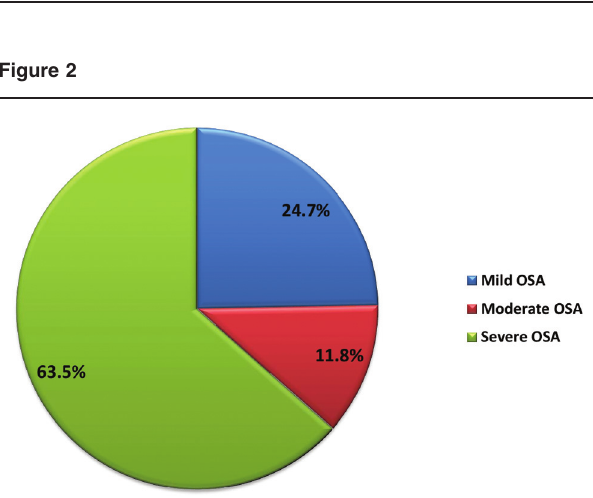
Frequency of IBSin patients with OSA. IBS,irritable bowel syndrome; OSA, obstructive sleep apnea